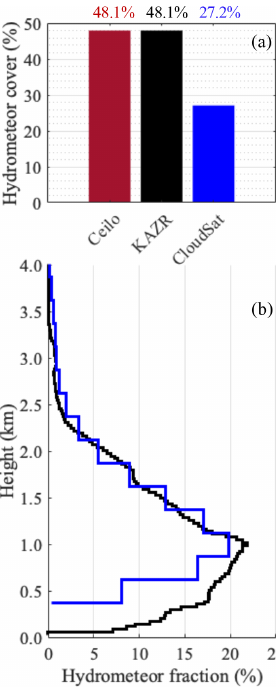
Figure 3. For 103 instances where CloudSat overpassed the 200km radius region centered on the ENA observatory, (a) fraction of ob- served profiles with cloud or rain (i.e., hydrometeor cover) and (b) hydrometeor fraction profile. Both estimated from CloudSat CPR observations within a 200km radius of the ENA observatory (blue) and ground-based KAZR observations collected within ± 1h of the CloudSat overpass (black). Fractions are estimated based on the total number of observed profiles excluding those determined to contain high, deep or ice